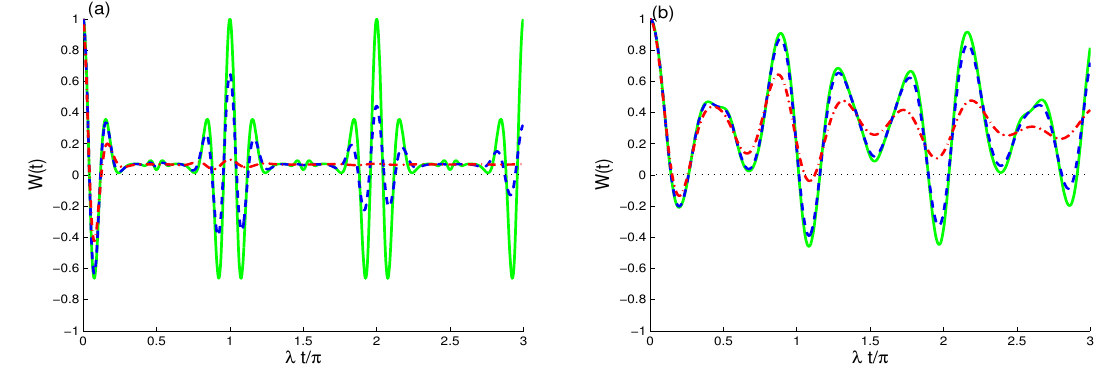
Figure 2. As Figure 1a,b but for ( k , α ) = ( 1,5 ) in ( a ) and ( k , α ) = ( 1 values of γ : γ / λ = 0 (green solid curves), γ / λ = 0.001 (blue dashed curves), and γ / λ = 0.01 (red dashed dot